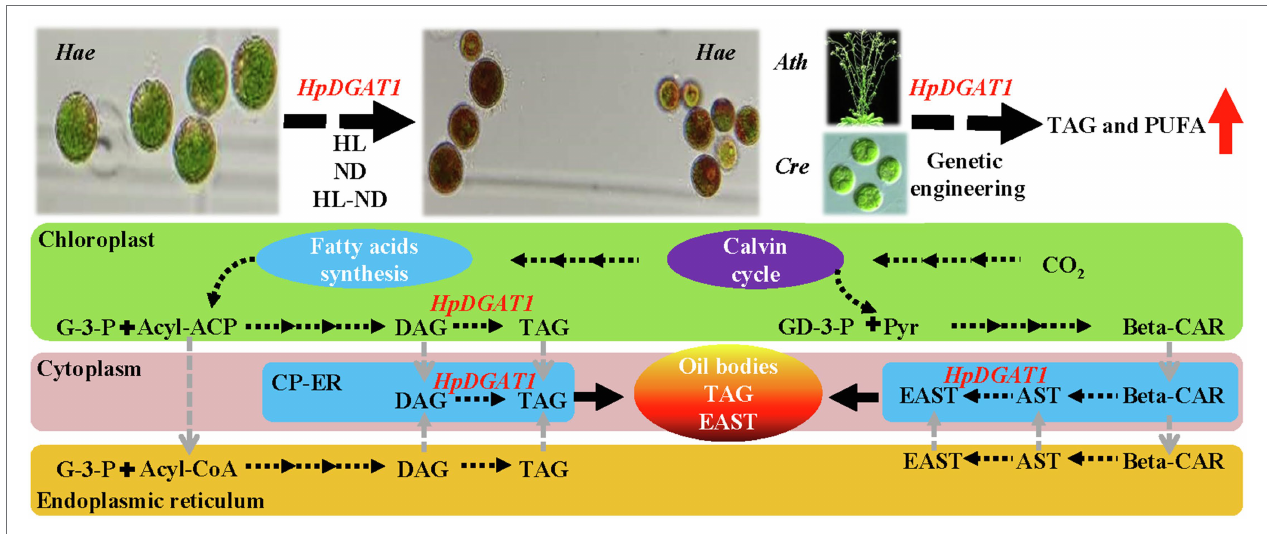
FIGURE 6 | A hypothesized working model illustrating the potential dual-function of HpDGAT1 in TAG and EAST biosynthesis in H. pluvialis. Briefly, under stress conditions, the HpDGAT1 transcript was obviously increased, which was accompanied by the significant increase of TAG and EAST contents. The genetic engineering of HpDGAT1 in Chlamydomonas reinhardtii ( Cre ) and Arabidopsis thaliana ( Ath ) significantly enhanced the MUFAs- and PUFAs-rich TAG accumulation. The de novo synthesized fatty acyls constitute the acyl-ACP or acyl-CoA pools, which consequently enter Kennedy pathway for the synthesis of TAG in cytoplasm endoplasmic reticulum (ER) or chloroplast ER (cER). HpDGAT1 could catalyze the prokaryotic TAG accumulation in chloroplast or probably located in cER (cER is expressed as an elbow-like line linking ER and chloroplast envelope) and utilized both the prokaryotic and eukaryotic DAGs for TAG assembly. In addition, EASTs might be synthesized in chloroplast ER or cytoplasm ER by HpDGAT1 enzyme, which is dependent on availability of free AST and acyl-CoAs. Finally, TAG and EAST are together packed into oil